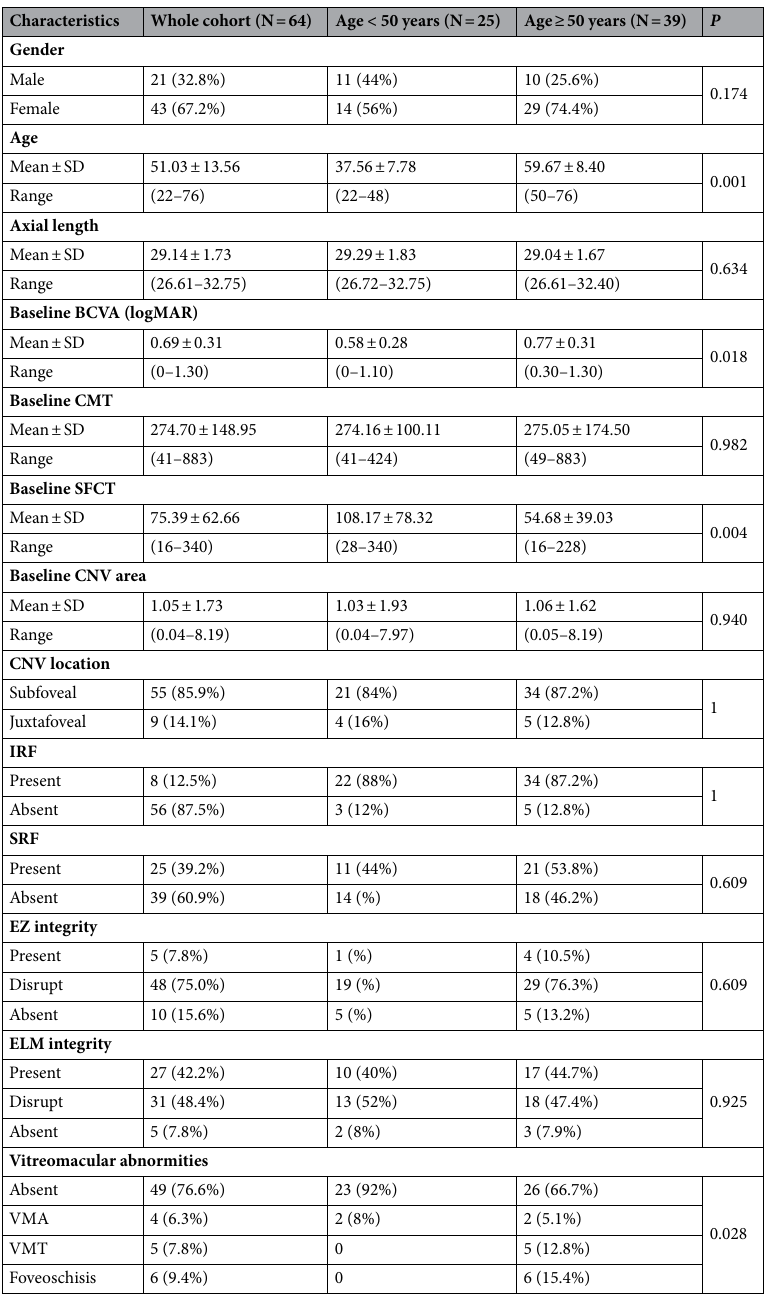
Table 1. Demographic and baseline characteristics of mCNV eyes and comparison between the younger group ( ˂ 50 years) and older group (≥ 50 years). BCVA best-corrected visual acuity, CMT central macular thickness, CNV choroidal neovascularization, ELM external limiting membrane, IRF intraretinal fluid, EZ ellipsoid zone, logMAR logarithm of the minimum angle of resolution, SD standard deviation, SFCT subfoveal choroidal thickness, SRF subretinal fluid, VMA vitreomacular adhesion, VMT vitreomacular